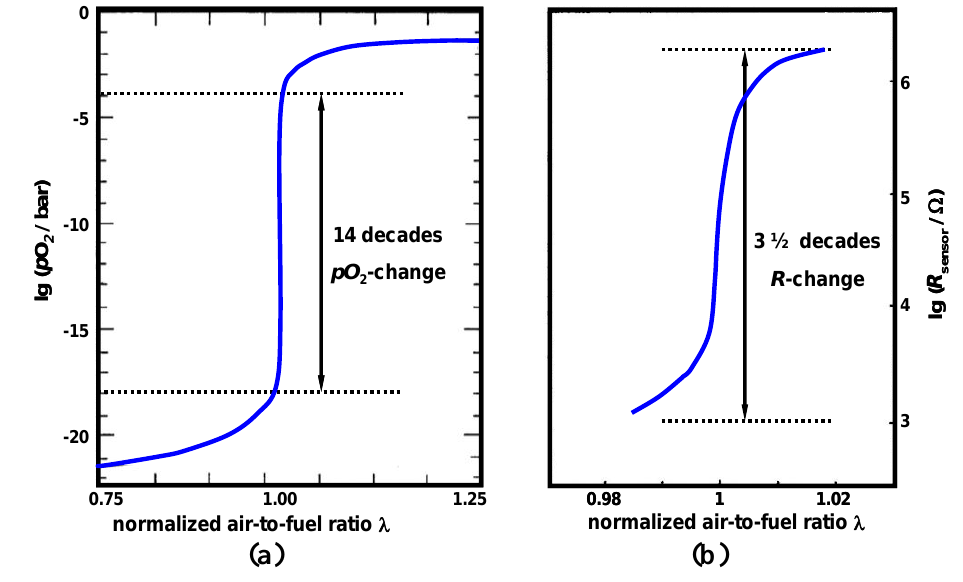
Figure 1. (a) Relationship between oxygen partial pressure and normalized air-to-fuel ratio  (modified after [6]). (b) Behavior of the sensor resistance vs . normalized air-to-fuel ratio  (modified after [10]) around the stoichiometric point at  =